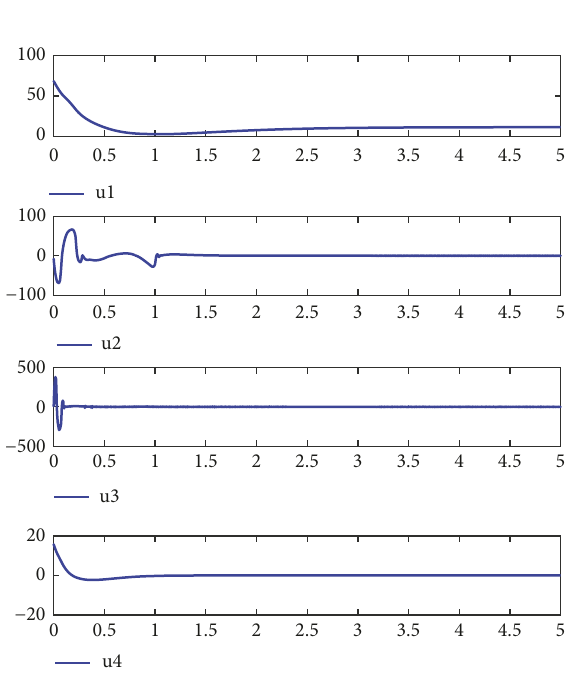
Figure 6: The control inputs of